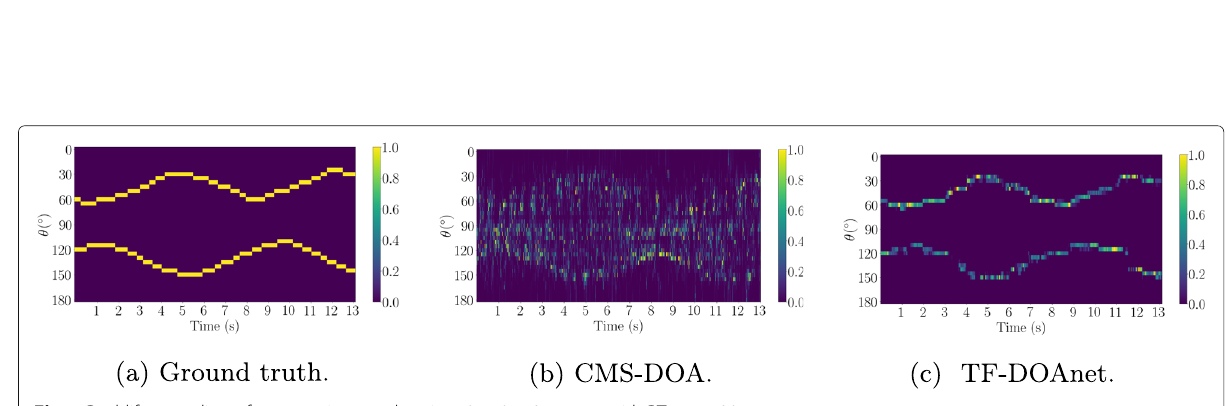
Fig. 4 Real-life recording of two moving speakers in a 6 × 6 × 2.4 room with RT 60 = 720